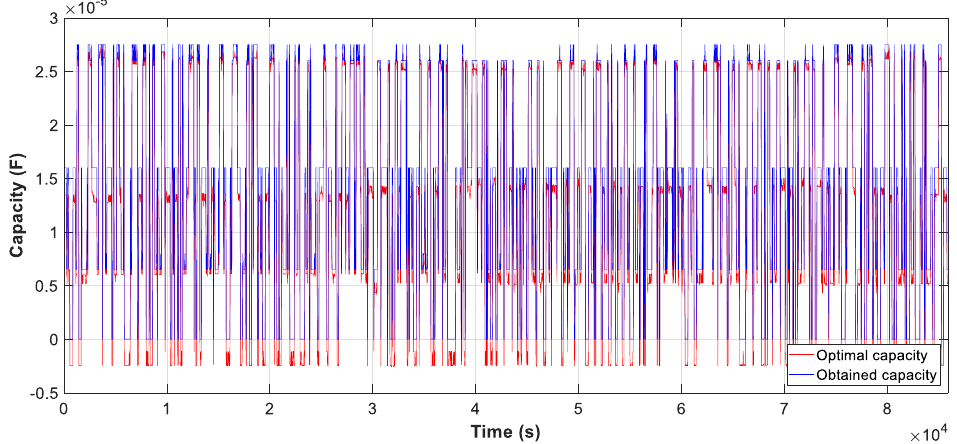
Figure 20. Comparison obtained vs optimal capacity of daily.